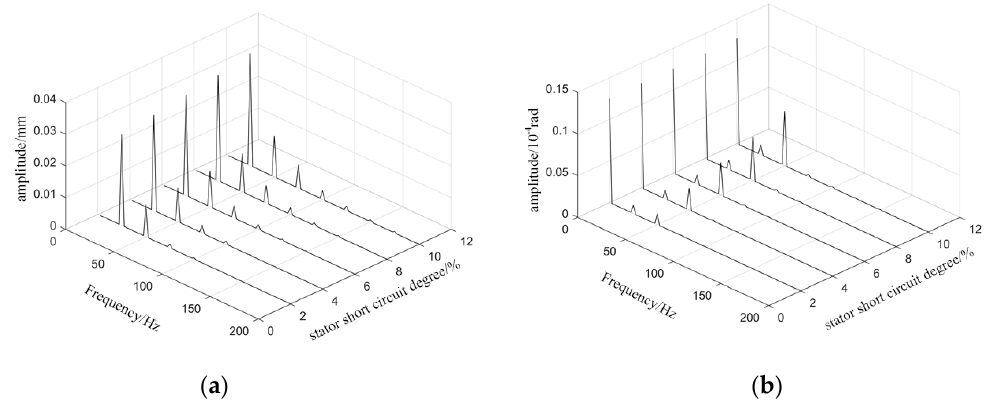
Figure 19. Coupled fault system response with misaligned 3 mm: ( a ) Radial vibration spectrum waterfall diagram; ( b ) Torsional vibration spectrum waterfall diagram.